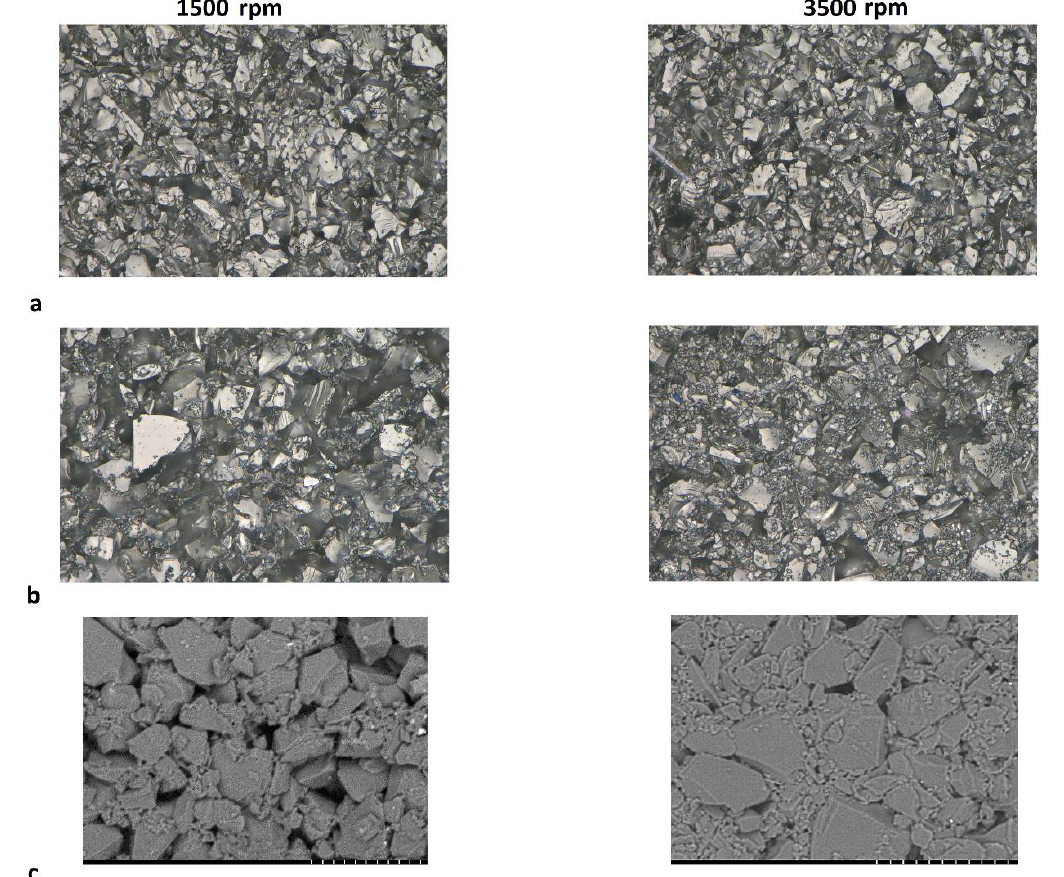
Figure 6. Images of the electrodes absent of carbon black mixed at 1500 rpm and 3500 rpm: ( a ) Kuranode hard carbon optically magnified 2500×, and ( b ) MTI hard carbon. SEM images, magnified 2000×, of the ( c ) MTI hard carbon samples. The scale bar represents 20 µm.